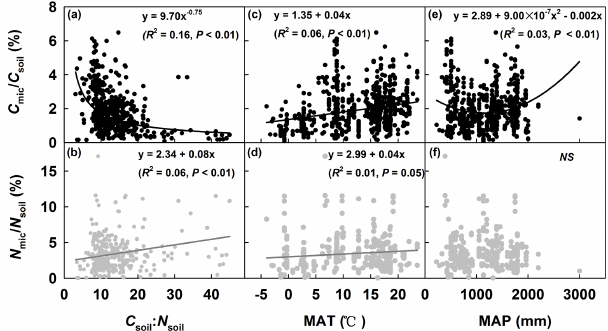
Figure 7. Relationships between C mic / C soil or N mic / N soil rate and C soil :N soil ratio (a, b) , MAT (c, d) , and MAP (e, f) , respec- tively. C soil , N soil , C mic , N mic , MAT, and MAP stand for soil or- ganic carbon, soil total nitrogen, microbial biomass carbon, mi- crobial biomass nitrogen, mean annual temperature, and mean an- nual precipitation, respectively. The regression models are given. NS stands for